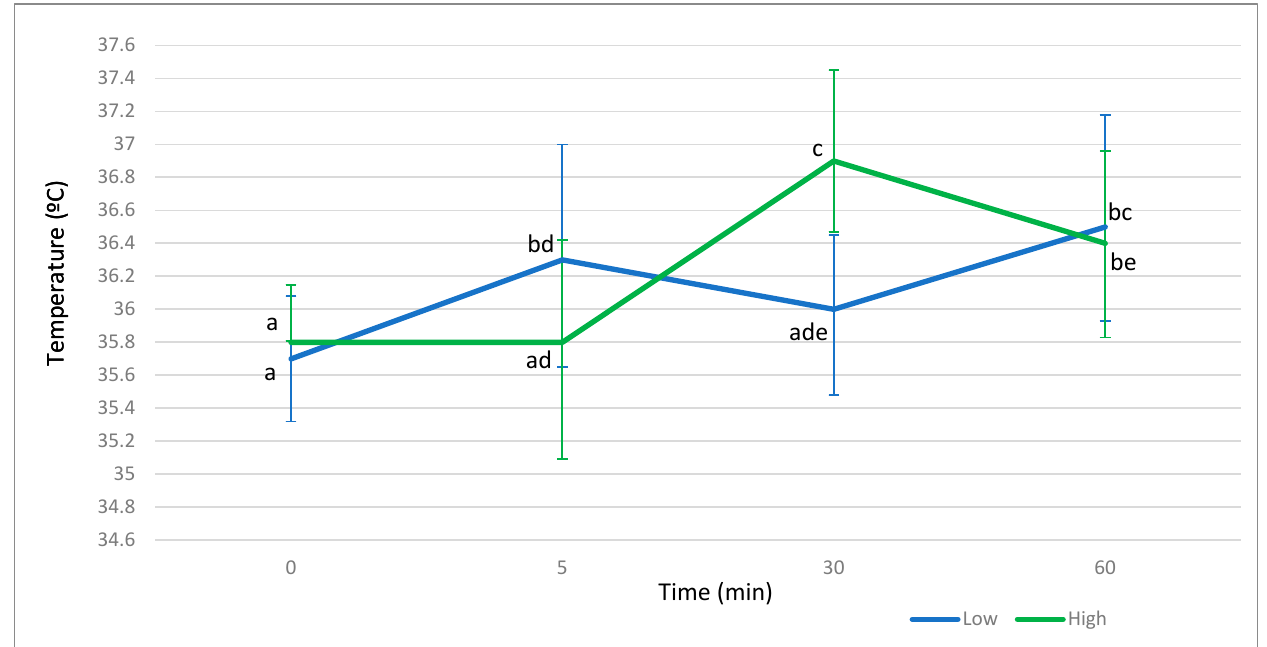
Figure 2. Evolution of eyeball temperature to basal time, 5 min, 30 min, and 60 min after stressful stimulus in the Low and the High line. Different letters mean differences with p greater than 0.90. Bars indicate highest posterior density region at 95%.